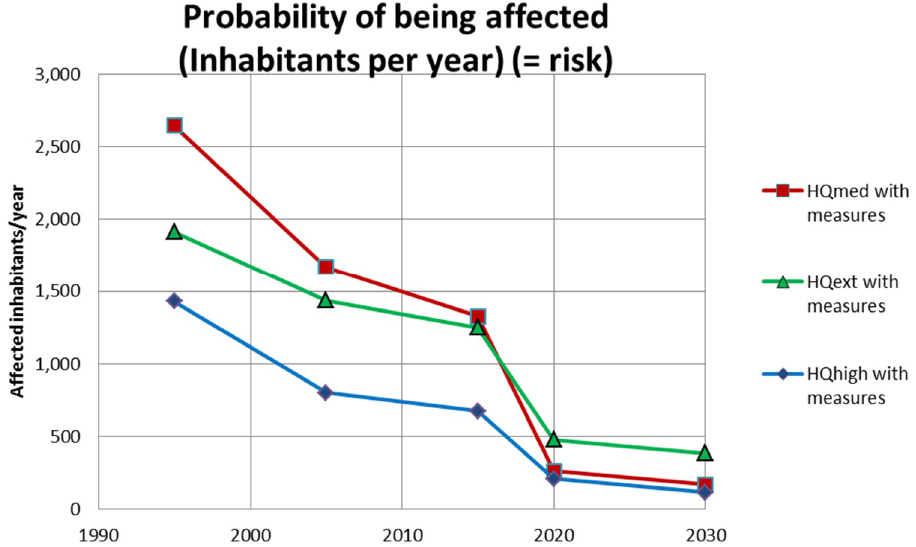
Figure 9. Probability of affected inhabitants with consideration of all measures (people affected/year) (= risk) [8].